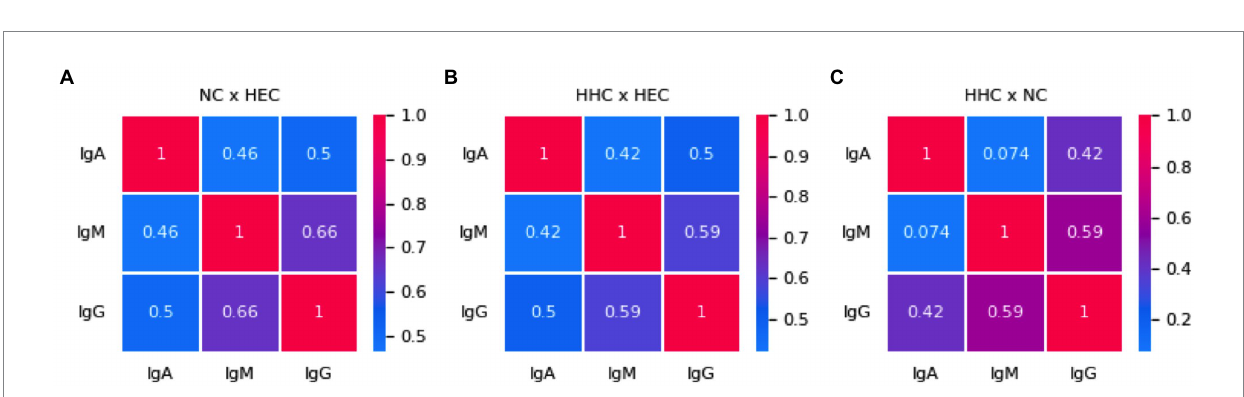
FIGURE 4 Immunoglobulins against Mce1A protein correlate weakly and moderately. Correlation matrix of α -Mce1A antibodies for NC and HEC (A) , HHC and HEC (B) , HHC and NC (C) . Spearman’s correlation coefficients between two pairs of variables are shown in the heatmap. Red to blue shades correspond to increasing values of Spearman’s correlation coefficient, as shown in the color bar. HEC, healthy endemic controls; HHC, household contacts of HD patients; NC, new cases of HD; IgA, immunoglobulin A; IgM, immunoglobulin M; IgG, immunoglobulin